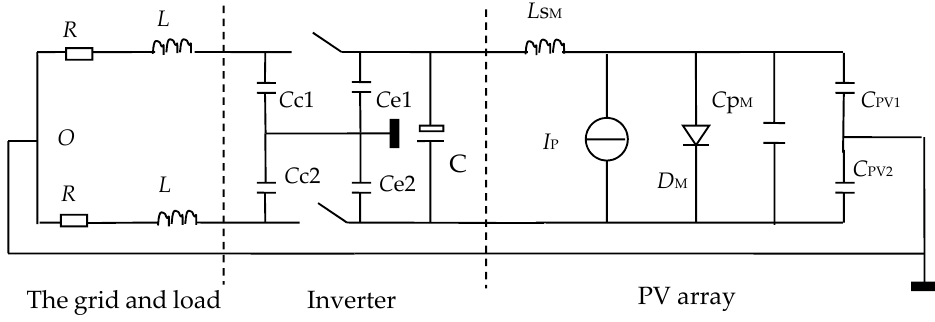
Figure 4. The simplified equivalent circuit for grid and load, inverter and PV module arrays.